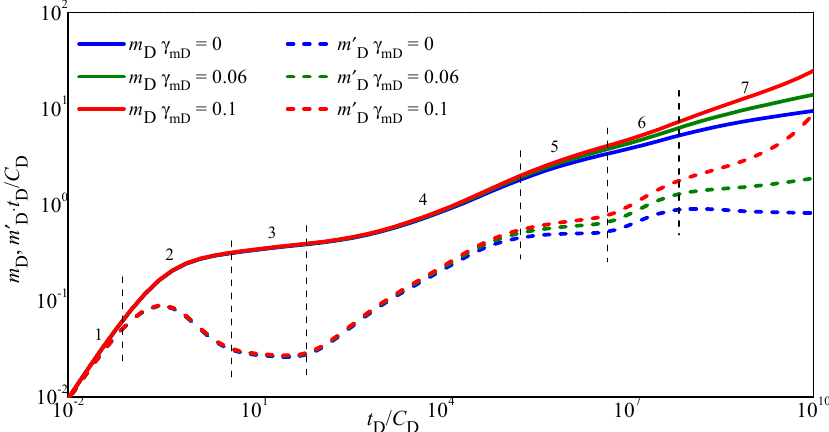
Figure 3. Influence of the permeability modulus on the pressure dynamic curve of a single medium composite reservoir.